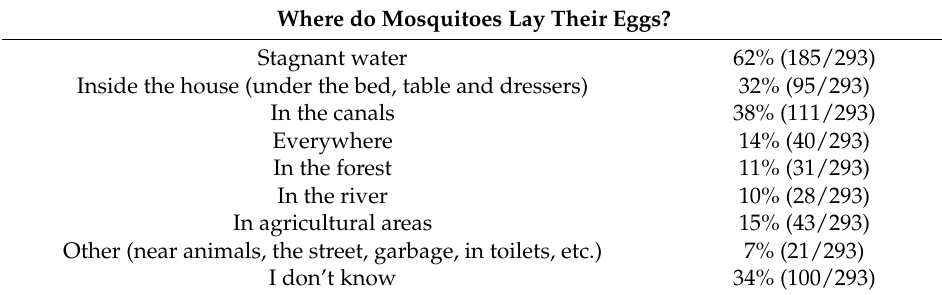
Table 3. Community Identification of Mosquito Breeding